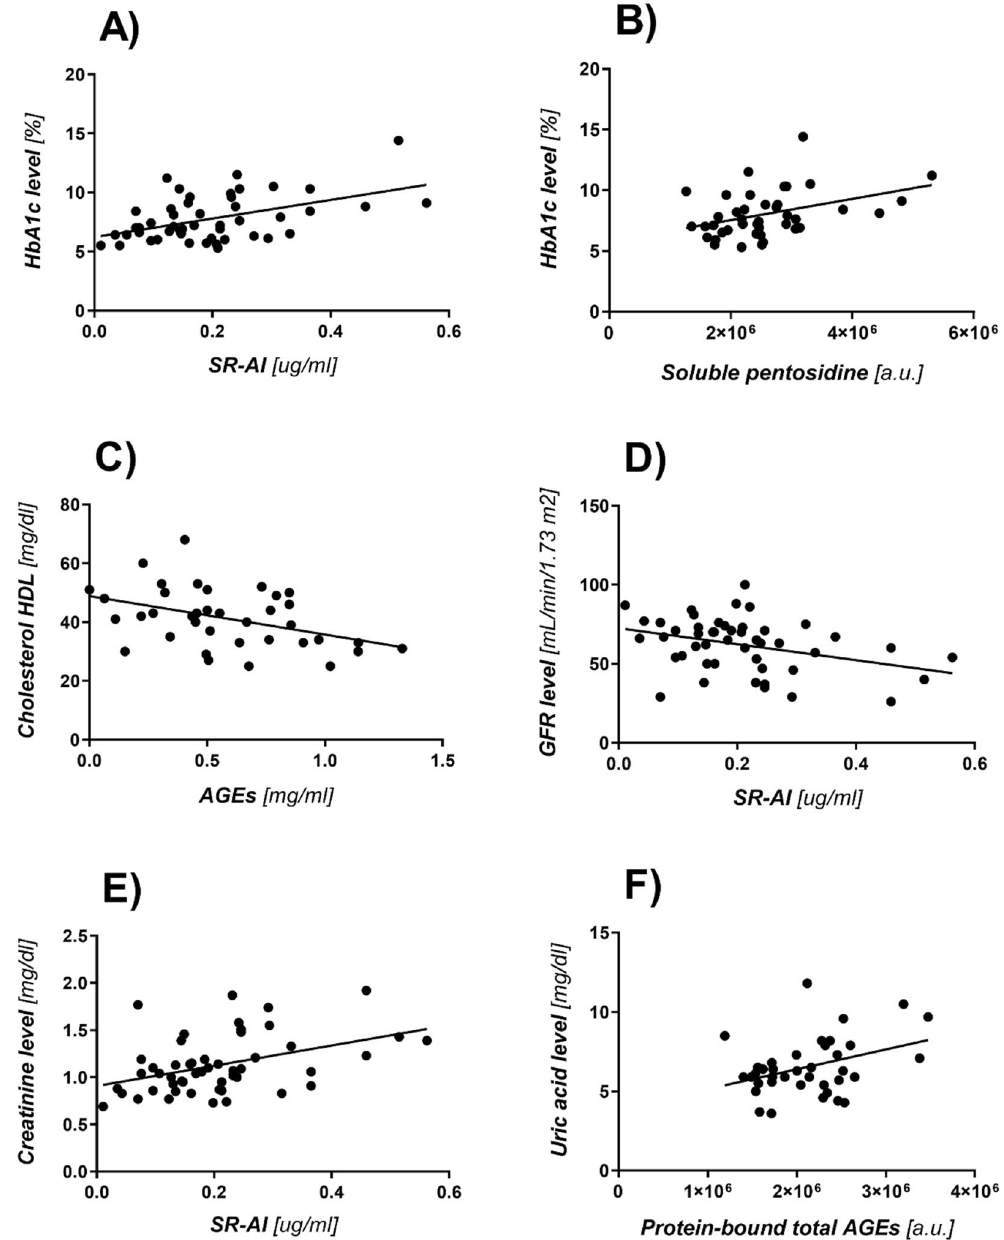
Figure 2. ( A ) Graph of the correlation between the level of glycated hemoglobin HbA1c and the concentration of the SR-AI scavenger receptor in the samples. ( B ) Graph of the correlation between the level of glycated hemoglobin HbA1c and fluorescence of soluble pentosidine. ( C ) Graph of the correlation between the concentration of HDL and AGEs content in samples digested with proteinase K (the competitive ELISA test). Graph of the correlation between the levels of GFR. ( D ) and creatinine. ( E ) and the concentration of the SR-AI receptor in the serum samples. ( F ) Graph of the correlation between the level of uric acid and the fluorescence value of protein-bound total AGEs in the serum